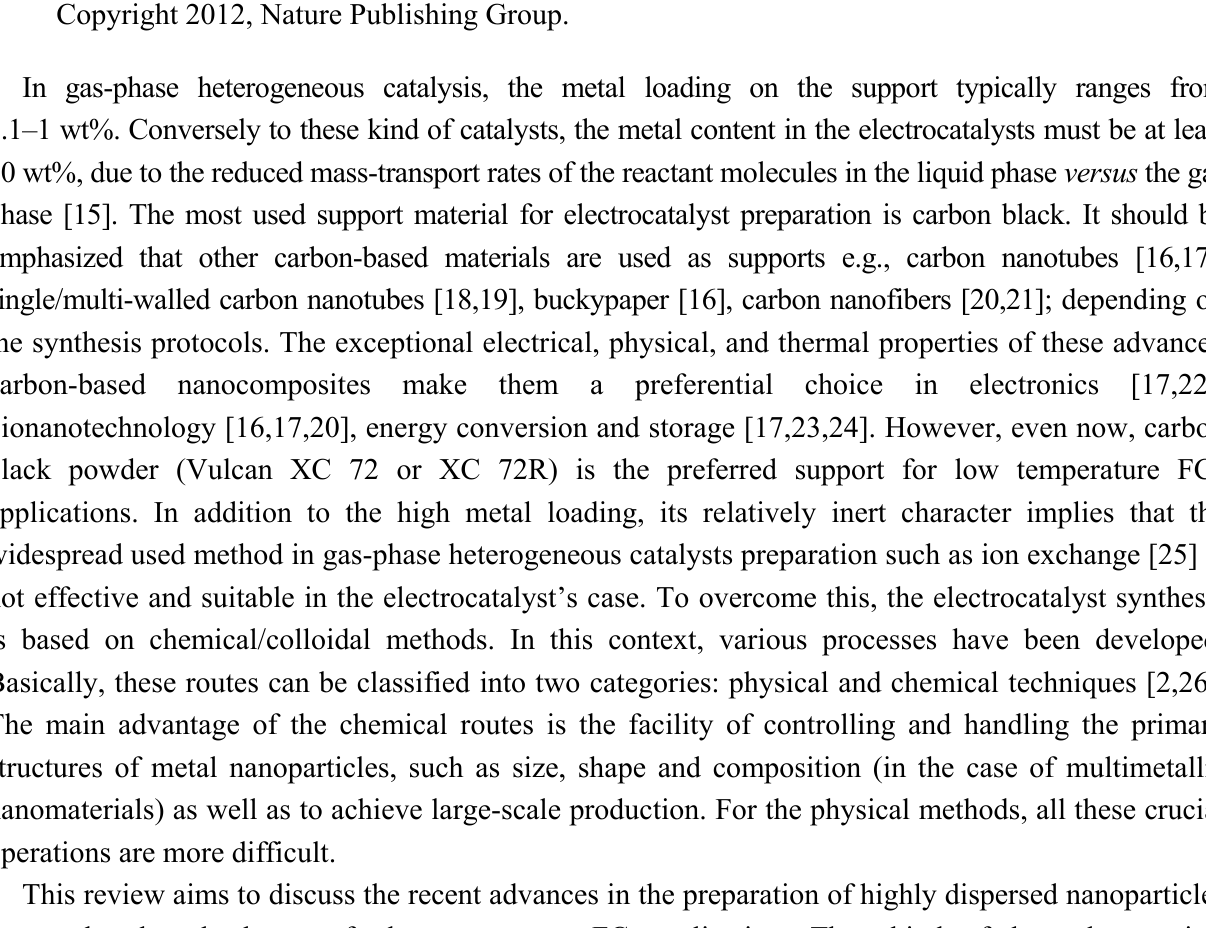
Figure 1. Kinetic activities of the main Pt-based electrocatalyst systems at 0.9 V vs. Reversible Hydrogen Electrode (RHE): ( a ) Activities are measured by rotating disc electrode (RDE) and ( b ) Activities are measured in membrane electrode assemblies (MEAs) at 80 °C and 150 kPa saturated O 2 . Reprinted with permission from Ref.